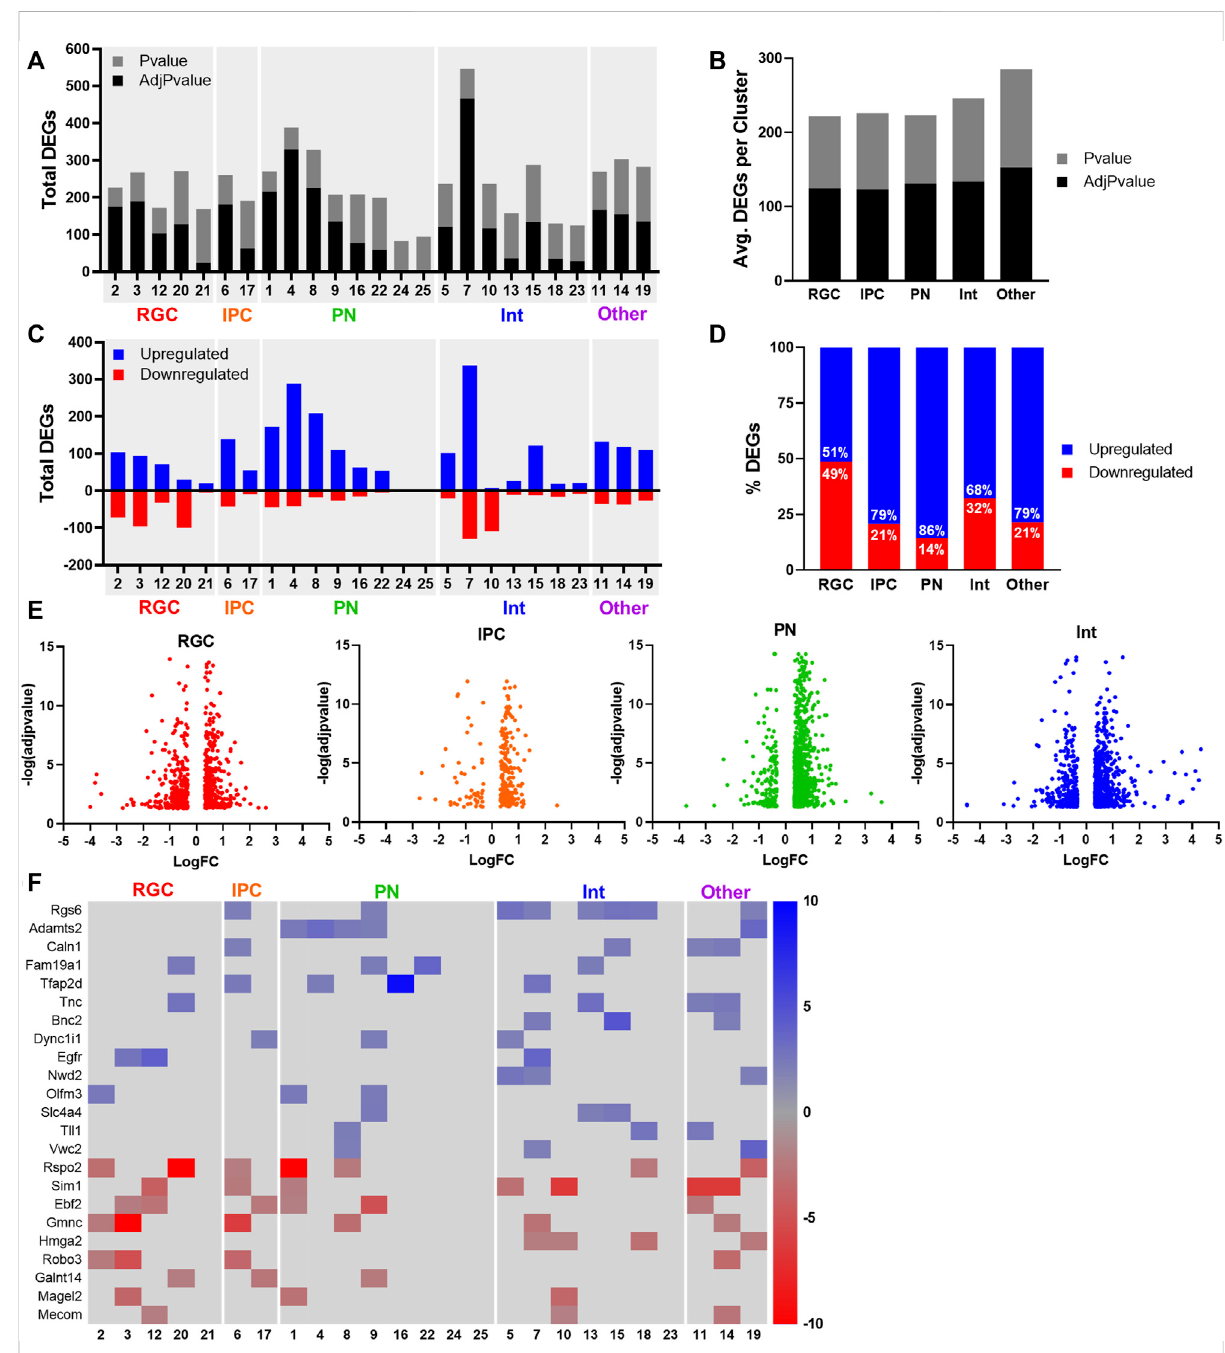
FIGURE 5 Differentially expressed genes after PAE. (A) Total nominal p -value ( p < 0.05) and adjusted p -value (adj. p < 0.05) signi fi cant differentially expressedgenes(DEGs)percluster. (B) Averagenumberofnominal p -value( p < 0.05)andadjusted p -value(adj. p < 0.05)signi fi cantDEGspercluster formajorcelltypes. (C) Totaldownregulated(red)andupregulated(blue)DEGspercluster. (D) ThepercentofupregulatedanddownregulatedDEGs per major cell type. (E) Volcano plots of the log fold change (logFC) and – log of the adjusted pvalue [-log (adjpvalue)] for all DEGs in major cell types. (F) Heatmap the fold change of DEGs sign fi cant in at least 3 clusters with fold change >